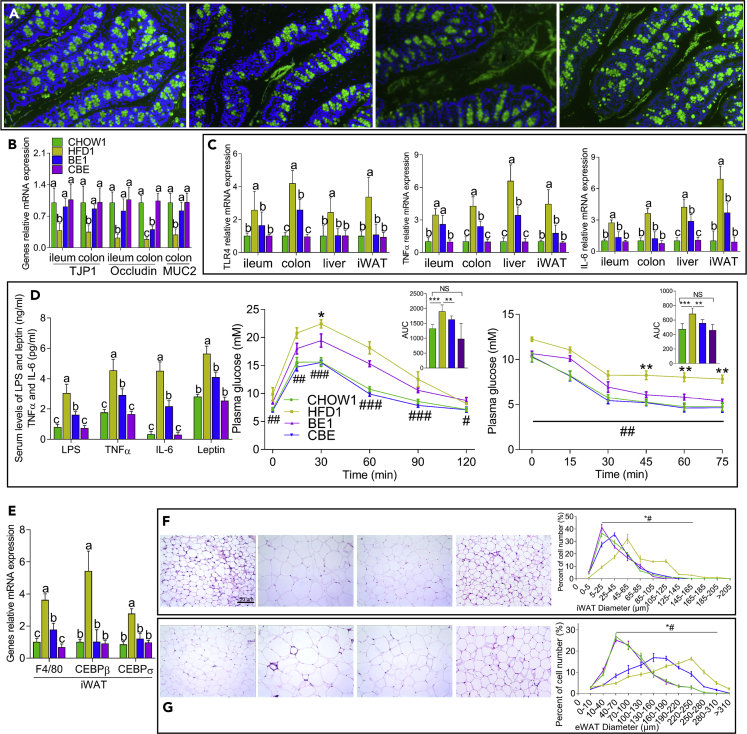
BE Treatment Ameliorated Systemic Inflammation and Improved Glucose Metabolism(A) Fluorescence microscope analysis of colonic MUC2 in mice from the CHOW1, HFD1, BE1, and CBE groups (from left to right). MUC2, green; DNA, blue; n = 10.(B and C) The relative mRNA expression of genes related to intestinal permeability (B) and inflammation (C).(D) The serum contents of inflammatory factors and changes in blood glucose concentrations. ∗p < 0.05, ∗∗p < 0.01 and ∗∗∗p < 0.001 for BE1 versus HFD1 and #p < 0.05, ##p < 0.01, and ###p < 0.001 for CHOW1 versus HFD1.(E) The relative mRNA expression of genes in iWAT.(F and G) Representative pictures showing the hematoxylin and eosin staining of iWAT (F) and eWAT (G) in CHOW1, HFD1, BE1, and CBE mice (from left to right) and the percentage of the cells with different diameters, ∗p < 0.05 for BE1 versus HFD1 and #p < 0.05 for CHOW1 versus HFD1. For all pictures, different letters indicate a significant difference between columns, p < 0.05.